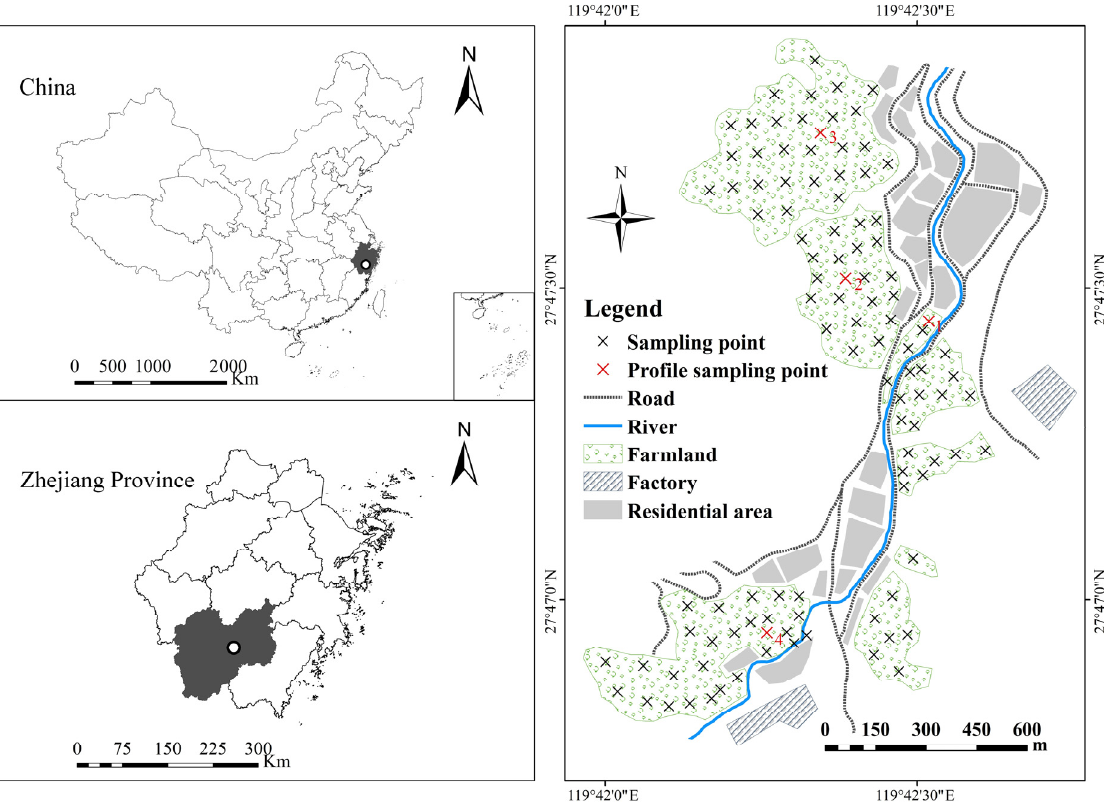
Figure 1. Distribution of sampling sites in the study area.